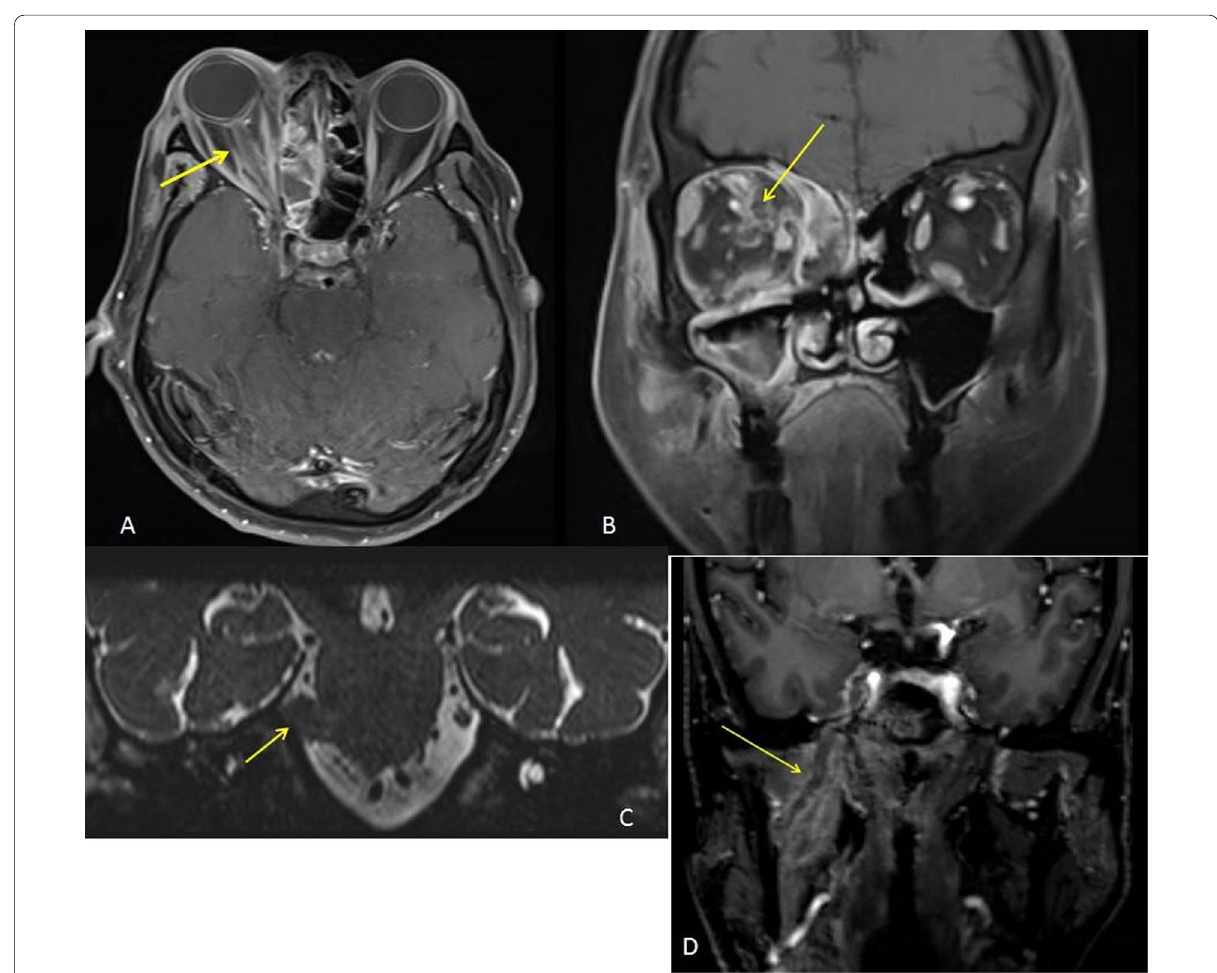
Fig. 4 A , B T1 post-contrast sequence in axial and coronal planes showing optic neuritis with changes of orbital cellulitis on the right side. C CISS in coronal plane shows thickened right trigeminal nerve. D T1 post-contrast sequence in coronal plane showing extensive post-contrast enhancement in the pterygoid muscles along the inferior alveolar nerve on the right